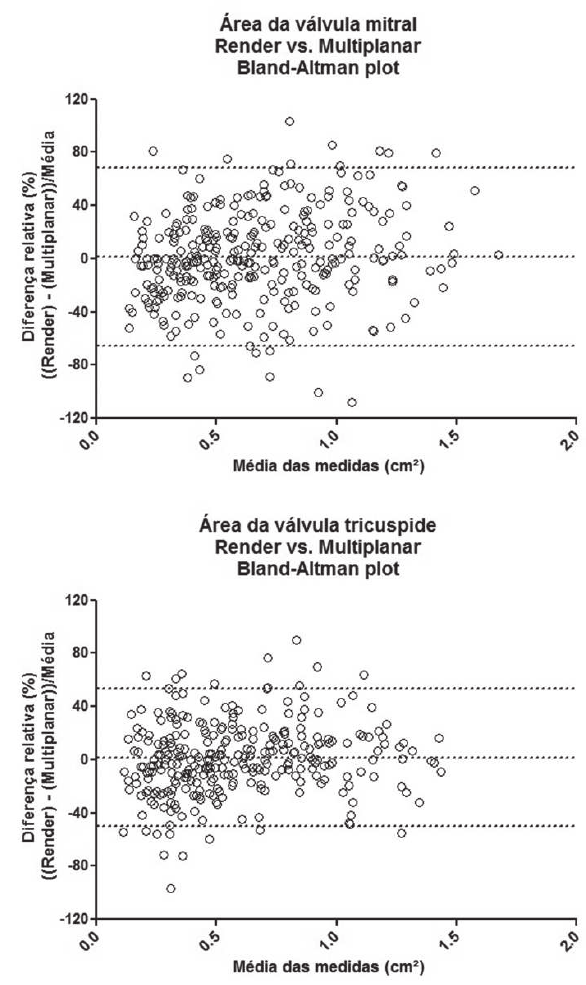
Fig. 2 - (A) Average relative difference between multiplanar and rendering modes plotted against the difference of means for measuring the area of the mitral valve. (B) Average relative difference between multiplanar and rendering modes plotted against the difference of means for measuring the area of the tricuspid